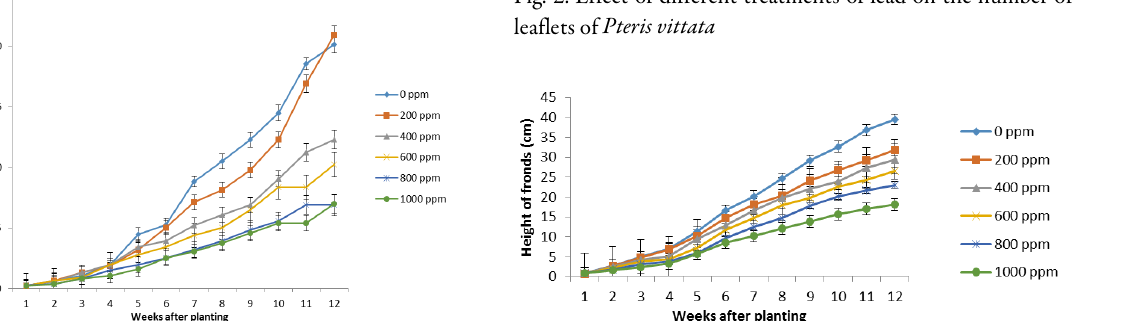
Fig. 4. Effect of different treatments of lead on the frond height of Pityrogramma